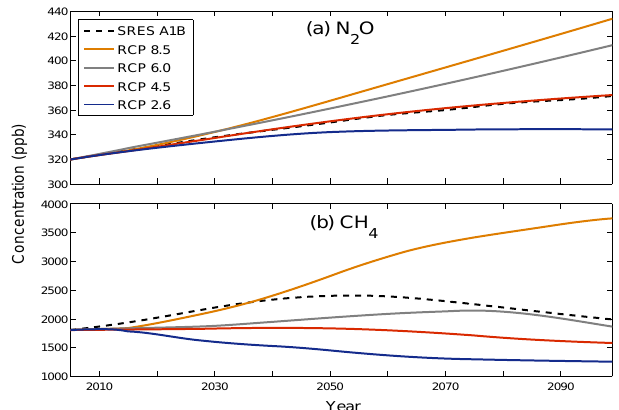
Fig. 1. (a) N 2 O and (b) CH 4 surface concentrations used in the CCM